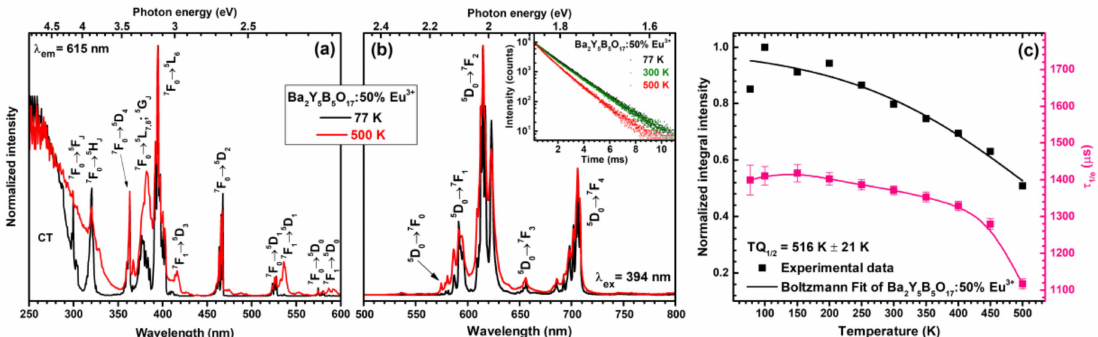
Figure 5. Excitation ( λ em = 615 nm) ( a ) and emission ( λ ex = 394 nm) ( b ) spectra of Ba 2 Y 5 B 5 O 17 :50%Eu 3 +